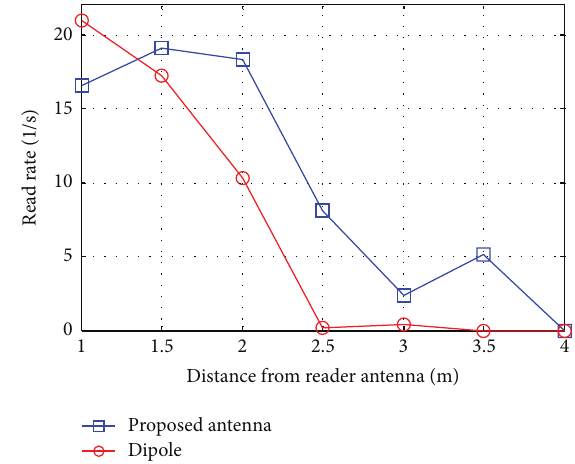
Figure 23: Measured read rates in the laboratory room with the antenna being worn on a human